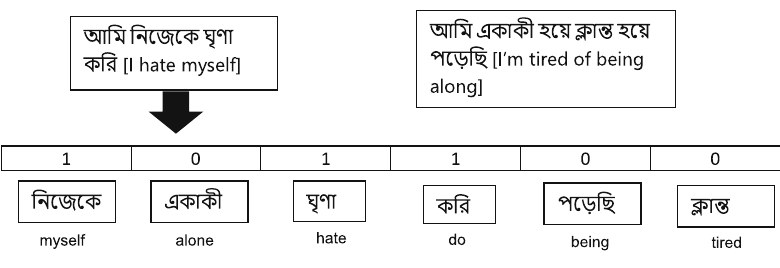
Figure 8: Example of word embedding.